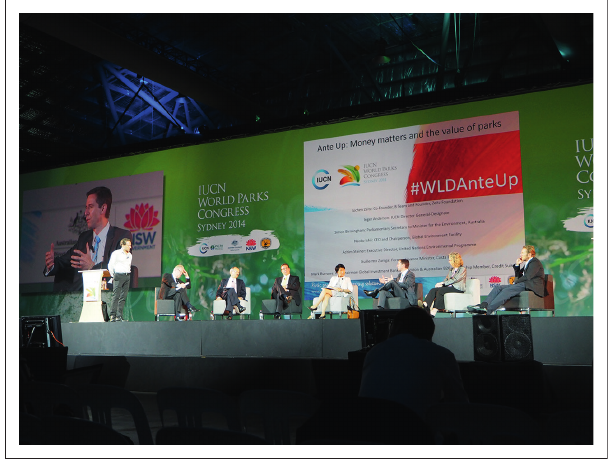
Source: Photograph taken by Ishbel Cullen FIGURE 2: Leaders of Pacific Island nations make a commitment to expand marine protected areas at the International Union for Conservation of Nature World Parks Congress